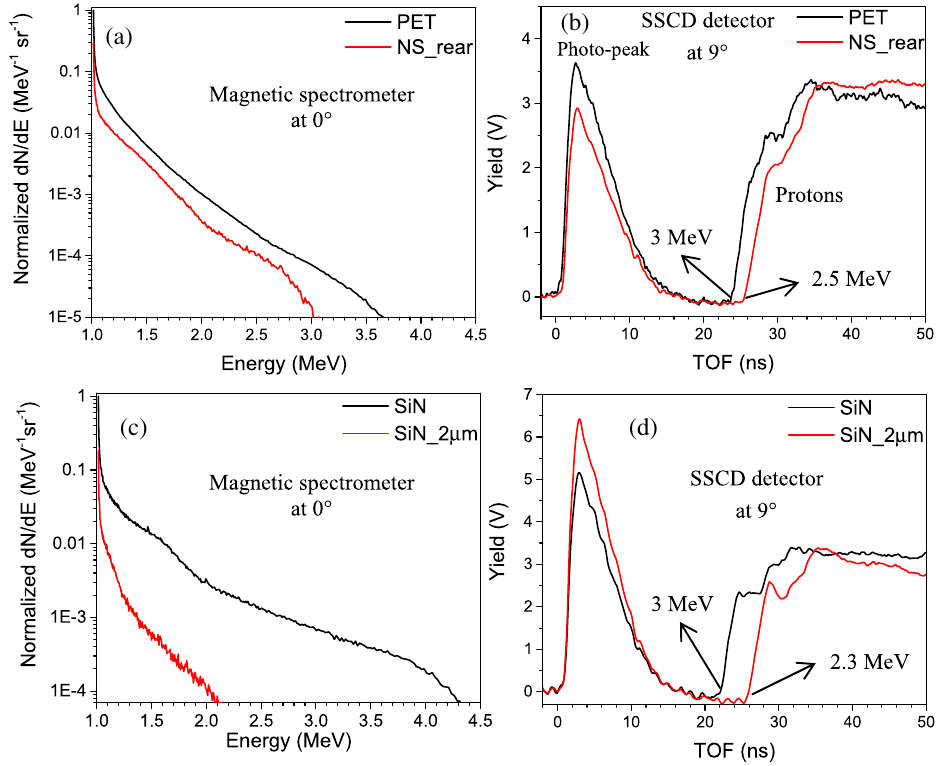
FIG. 3. Proton energy distributions measured by the magnetic spectrometer for PET and NS corresponding TOF spectra from the SSCD detector are shown in (b) and